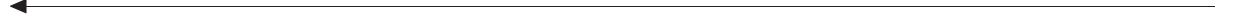
FIGURE 7 Immunofluorescence of frozen sections from 6 month old FVB and K14E7 thymii shows increased compartmentalization of keratin- staining, T cell and fibroblast areas in the transgenic thymus. Mice had received two doses of BrdU (5 and 1h prior to thymus harvest) to allow an analysis of proliferation. BrdU-FITC incorporation (green) is most intense in the cortical area (c) of both K14E7 (A) and FVB (B) thymii (Magnigication £ 100). Keratin 14-staining (blue) encircles area of mature T cells (CD3-red) which accumulate around large blood vessels. K14E7 mice have more densely packed K14 þ areas, these areas incorporated BrdU at a higher level than do the more scattered K14 þ areas of the FVB thymus. (C) Keratin 8 (red) compartmentalization is clearly shown as distinct from the K14 þ areas (blue) of this K14E7 thymus (Magnification £ 400). The majority of BrdU incorporation (green) occurs outside the K8 þ /K14 þ areas, however, a significant proportion is detected in K14 þ areas and the areas encircled by K14 þ cells. (D) The FVB thymus has less discrete bundles of K14 þ (orange) and K8 þ (green) epithelium. Extensive overlap occurs and the breakdown of architectural compartmentalization which occurs with age is apparent (Magnification, £ 400). (E) Keratin (k) encircled fibroblast pockets (f) are dispersed through the K14E7 thymus. The use of fibroblast specific MTS15 antibody (green) on sections of the K14E7 thymus, shows these keratin-enclosed areas to clearly partitioned from the rest of the medulla. A pankeratin marker (red) is used in this section (Magnification £ 100). (F) There is no similar compartmentalization of fibroblast accumulations in an equivalent preparation of FVB thymus. (G) The rate of cell cycling in these K14E7 fibroblast pockets was shown through the detection of BrdU incorporation (green). The keratin surrounding the fibroblast accumulations was shown to be keratin 14 (blue). MTS-7 (red) was used as an alternative fibroblast-specific antibody. BrdU incorporation was predominately confined to the cortical areas (c) with lower levels of proliferation occurring in these K14 þ or MTS-7 þ areas.